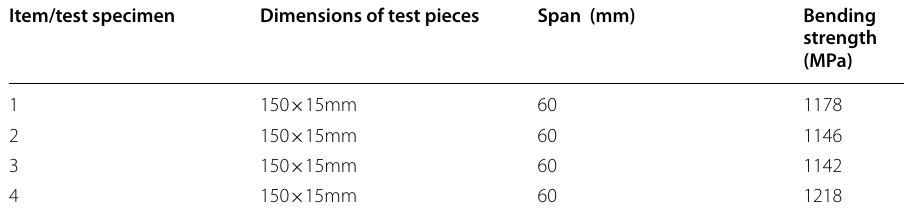
Table 7 Bending test